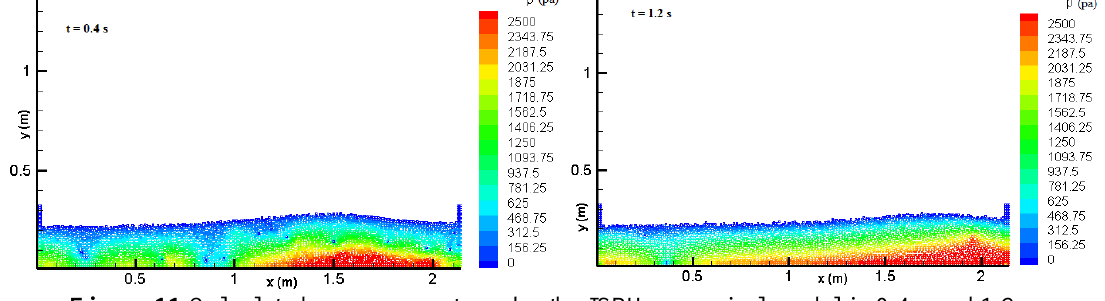
Figure 11 Calculated pressure contours by the ISPH numerical model in 0.4 s and 1.2 s. In Figure 11, the pressure contours at the time of 0.4 s and 1.2 s are shown. As may be observed the pressure contours are almost regular. At the time of 0.4 s, the pressure at the peak of wave approximately equals to the hydrostatic pressure measured at this point (=2900 pa). Figures 12 and 13 respectively indicate the normalized diagram of time in comparison to position of solitary wave